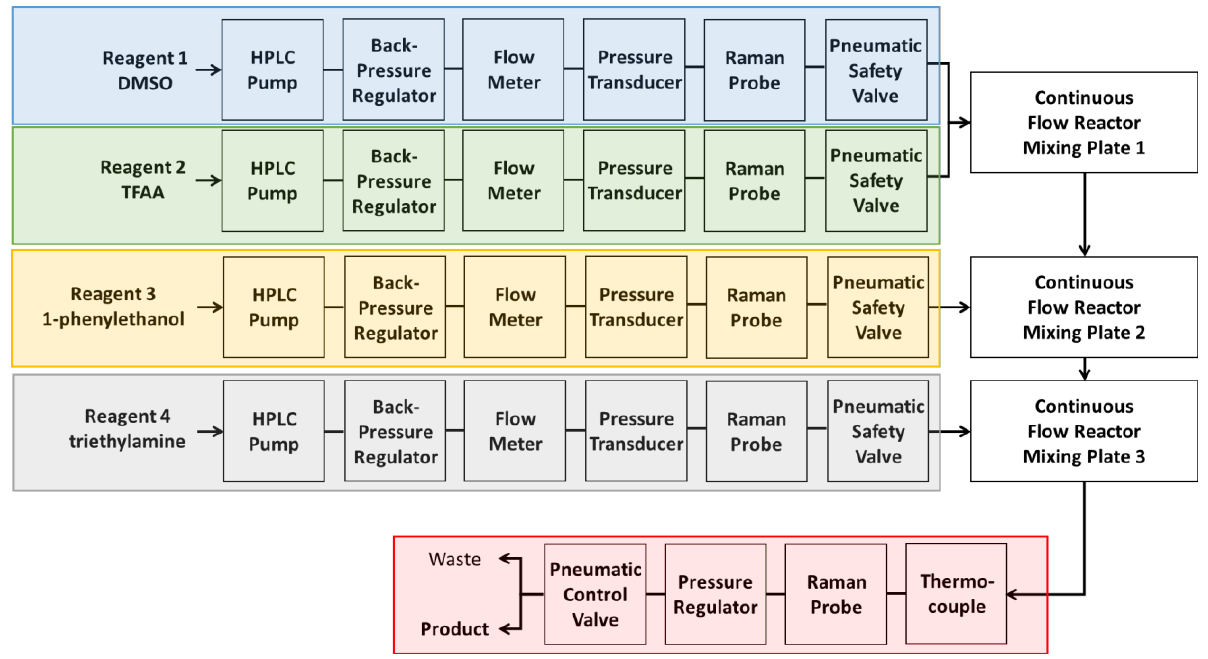
Figure 3. Schematic of continuous flow reactor system. Each of the four reagent lines have the same analytics present: Flow meter, pressure sensor, Raman probe, and valves for operator safety. The first two reagent lines combine in the first reactor, with each subsequent line adding a reagent to the next reactor. The product line contains a Raman probe, a pressure regulator, and a pneumatic valve that is able to send the chemical output to either product collection or